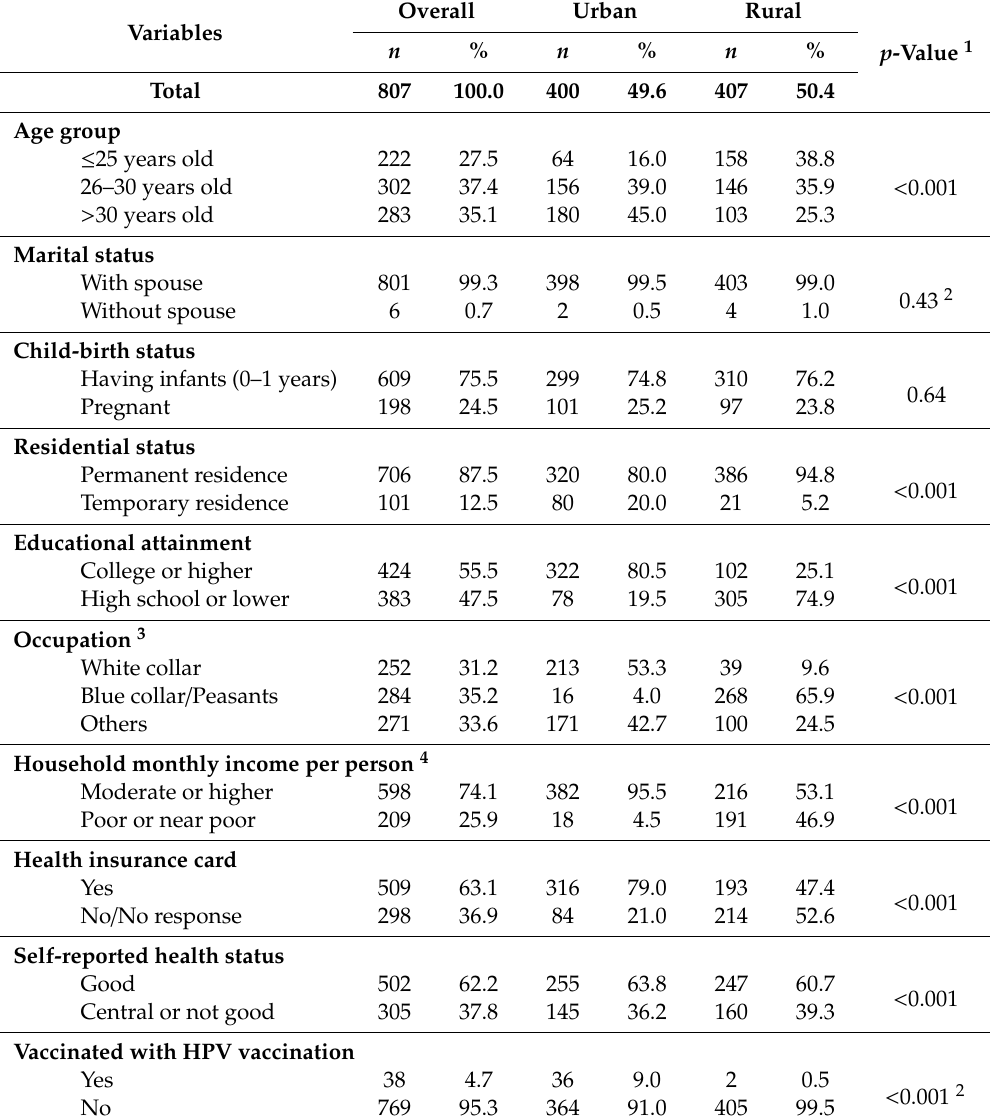
Table 1. Participant’s demographic characteristics.